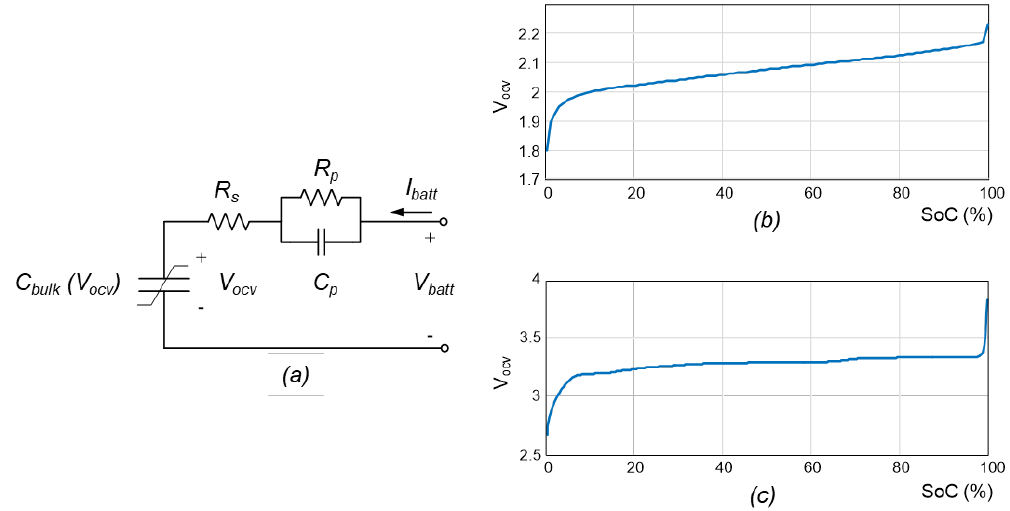
Figure 6. OTC Non-linear capacitance model ( a ), SoC–Vocv curve for VRLA technology ( b ), SoC–Vocv curve for LiFePO 4 battery ( c ).